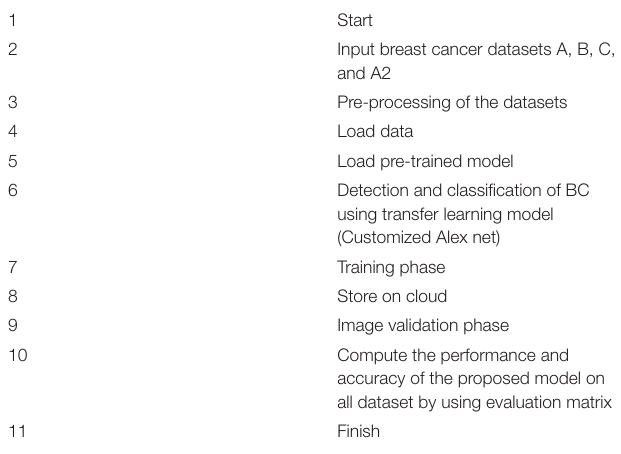
TABLE 2 | Pseudocode of the proposed model.